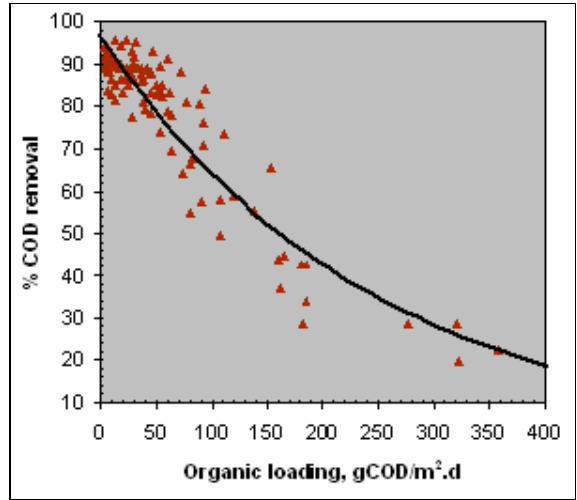
Figure 9: Effect of organic loading on the COD removal